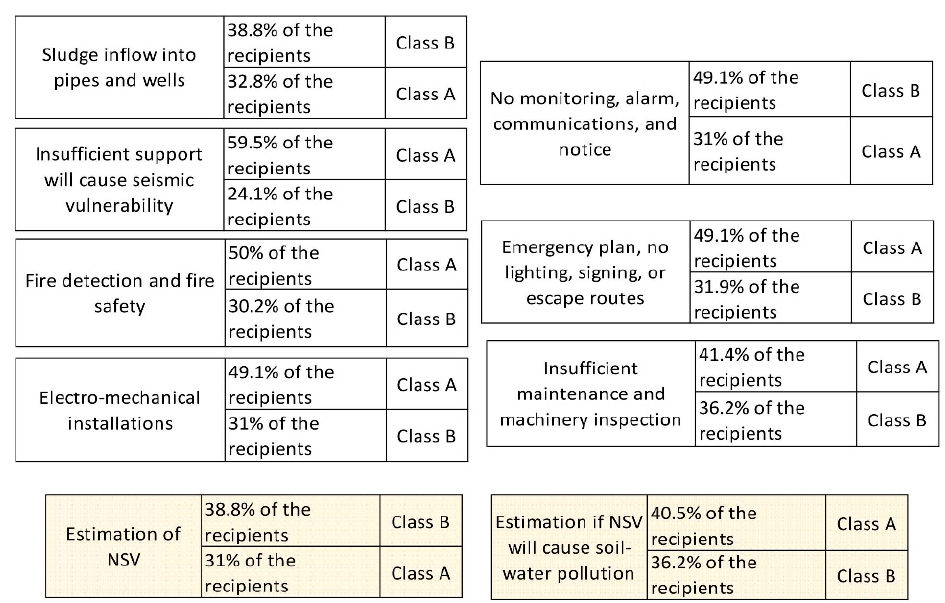
shown in Figure 10. Figure 9. NSV of the WWTPs in the post-seismic period in Greece.